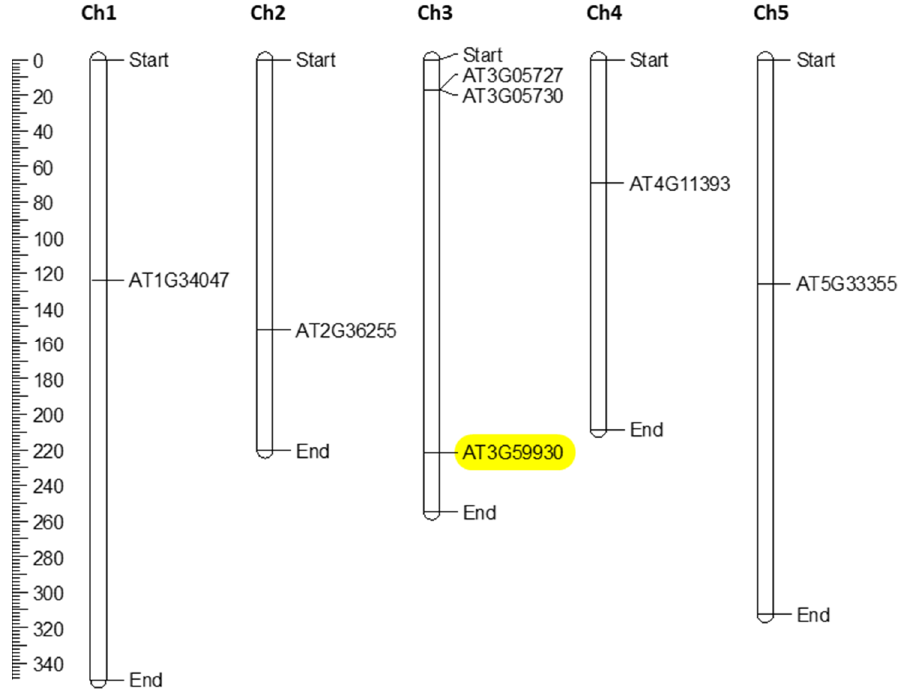
Figure 3. Chromosomal positioning of Arabidopsis CRP0770 genes. The scale on the left side of the figure gives the chromosomal length (in mega base pairs). The chromosomal number is shown at the top of the figure. The At3g59930 gene is highlighted in yellow.